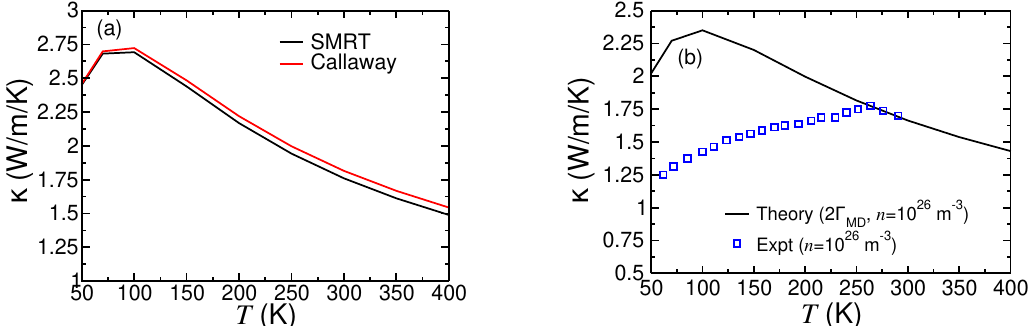
Figure 8. Thermal conductivity of Si(2.2 nm)/Ge(2.2 nm) PSL, with smaple size L = 400 nm, n-type doping concentration n = 10 26 m − 3 , and IMS factor ζ = 2.3. ( a ) Results are presented using both SMRT and Callaway theories with L = 400 nm. ( b ) Comparison between Callaway theory (this study) and experiment (Ref. [33]), with point mass defect concentration taken as twice of the isotopic mass factor and L = 300